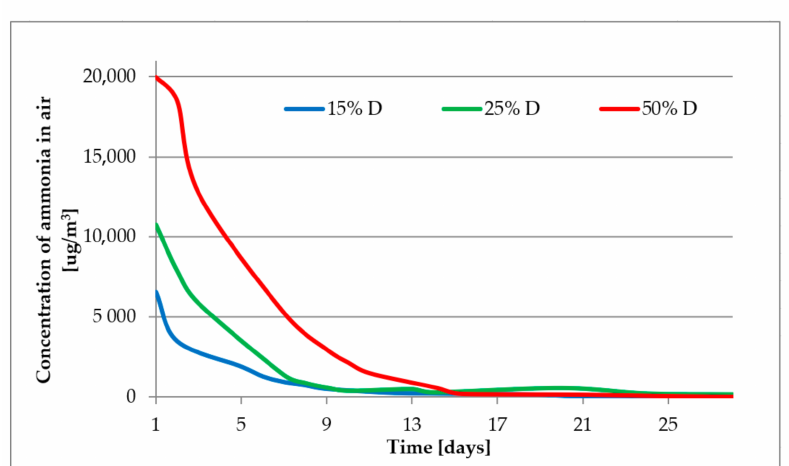
Figure 9. Emission of ammonia from mortars—sample D.